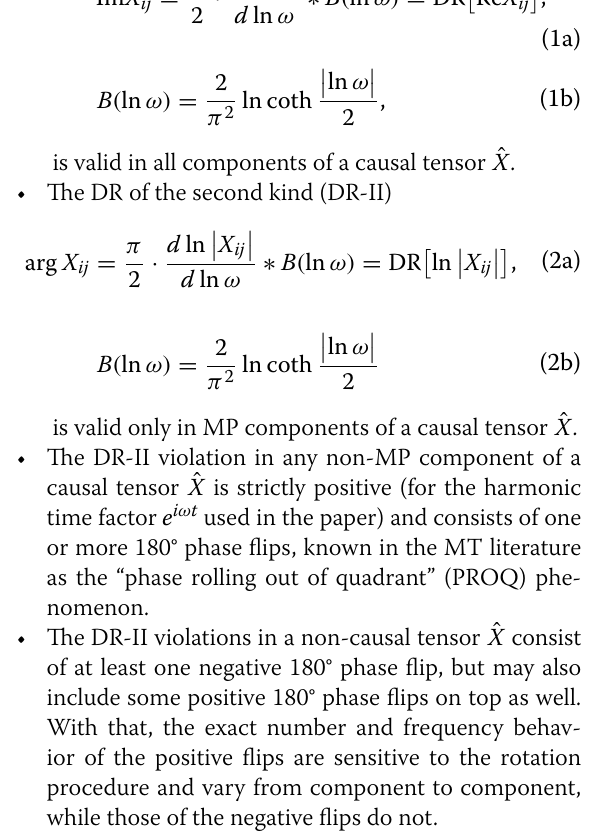
ˆ X from the standpoint of the DR validity